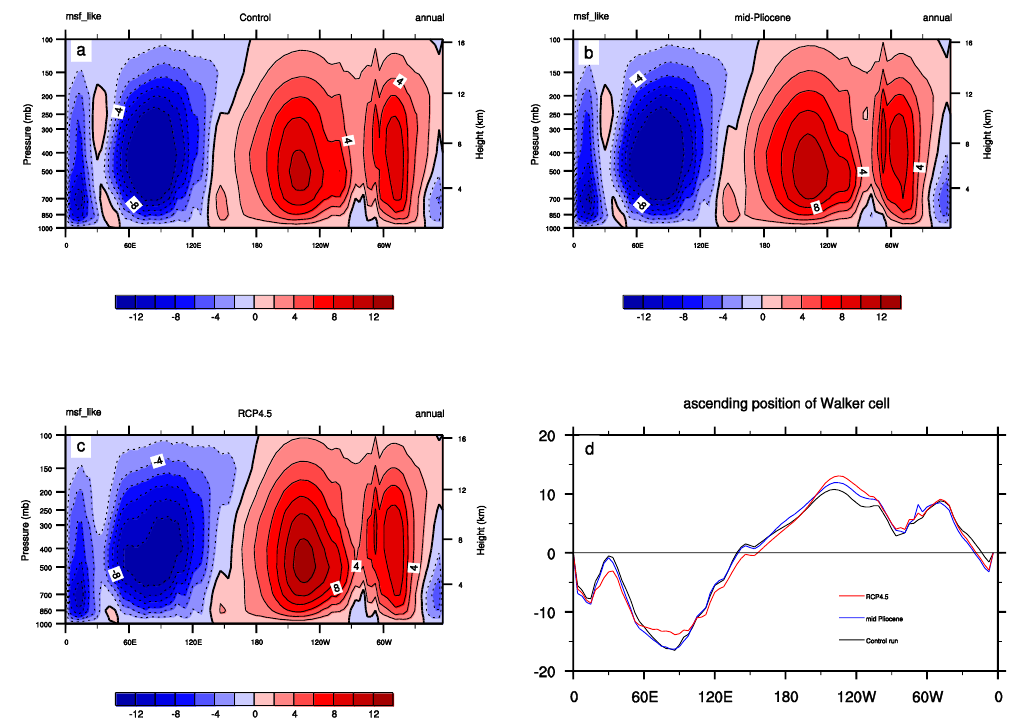
Fig. 4. MSF-like function (units: 10 10 kgs − 1 ) simulated by three different simulations (control run, mid-Pliocene, and RCP4.5 scenario) Fig. 4 MSF-like function (units: 10 10 Kg s -1 ) simulated by three different simulations 2 as displayed in (a–c) , respectively, and the MSF-like function at 500hPa used for description of the longitudinal position of the ascending branch of the Walker cell (d) (control run, mid Pliocene and RCP4.5 scenario) as displayed in (a-c) , respectively 3 and MSF-like at 500hPa used for description of longitudinal position of ascending 4 branch of Walker cell (d) . 5